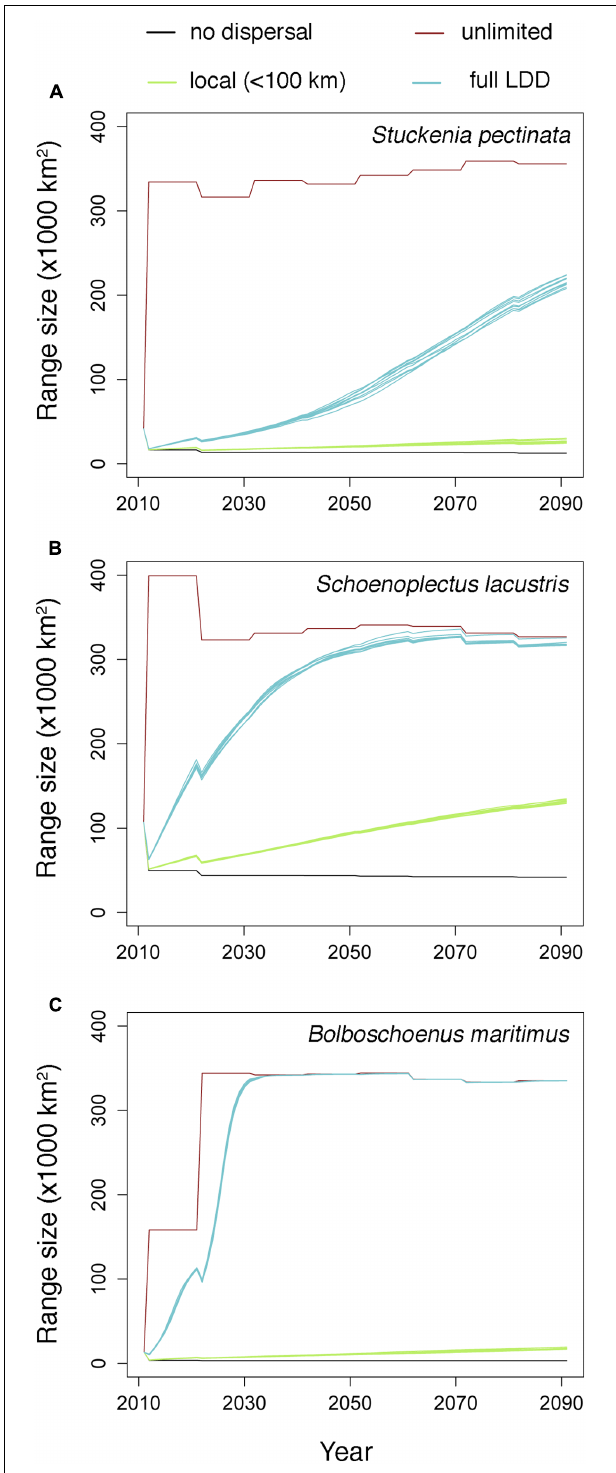
FIGURE 1 | Estimated range expansion for the three aquatic plant species under climate change according to the different dispersal scenarios. The multiple lines for each dispersal scenario (where appreciable) correspond to simulation replicates ( N = 10). (A) Stuckenia pectinata ; (B) Schoenoplectus lacustris ; (C) Bolboschoenus maritimus